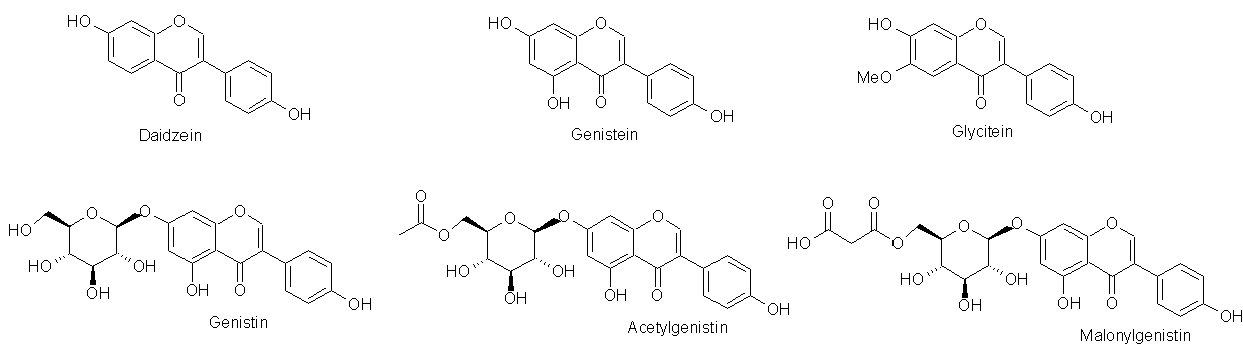
Figure 1 . Soybean isoflavone aglycones and genistein conjugated